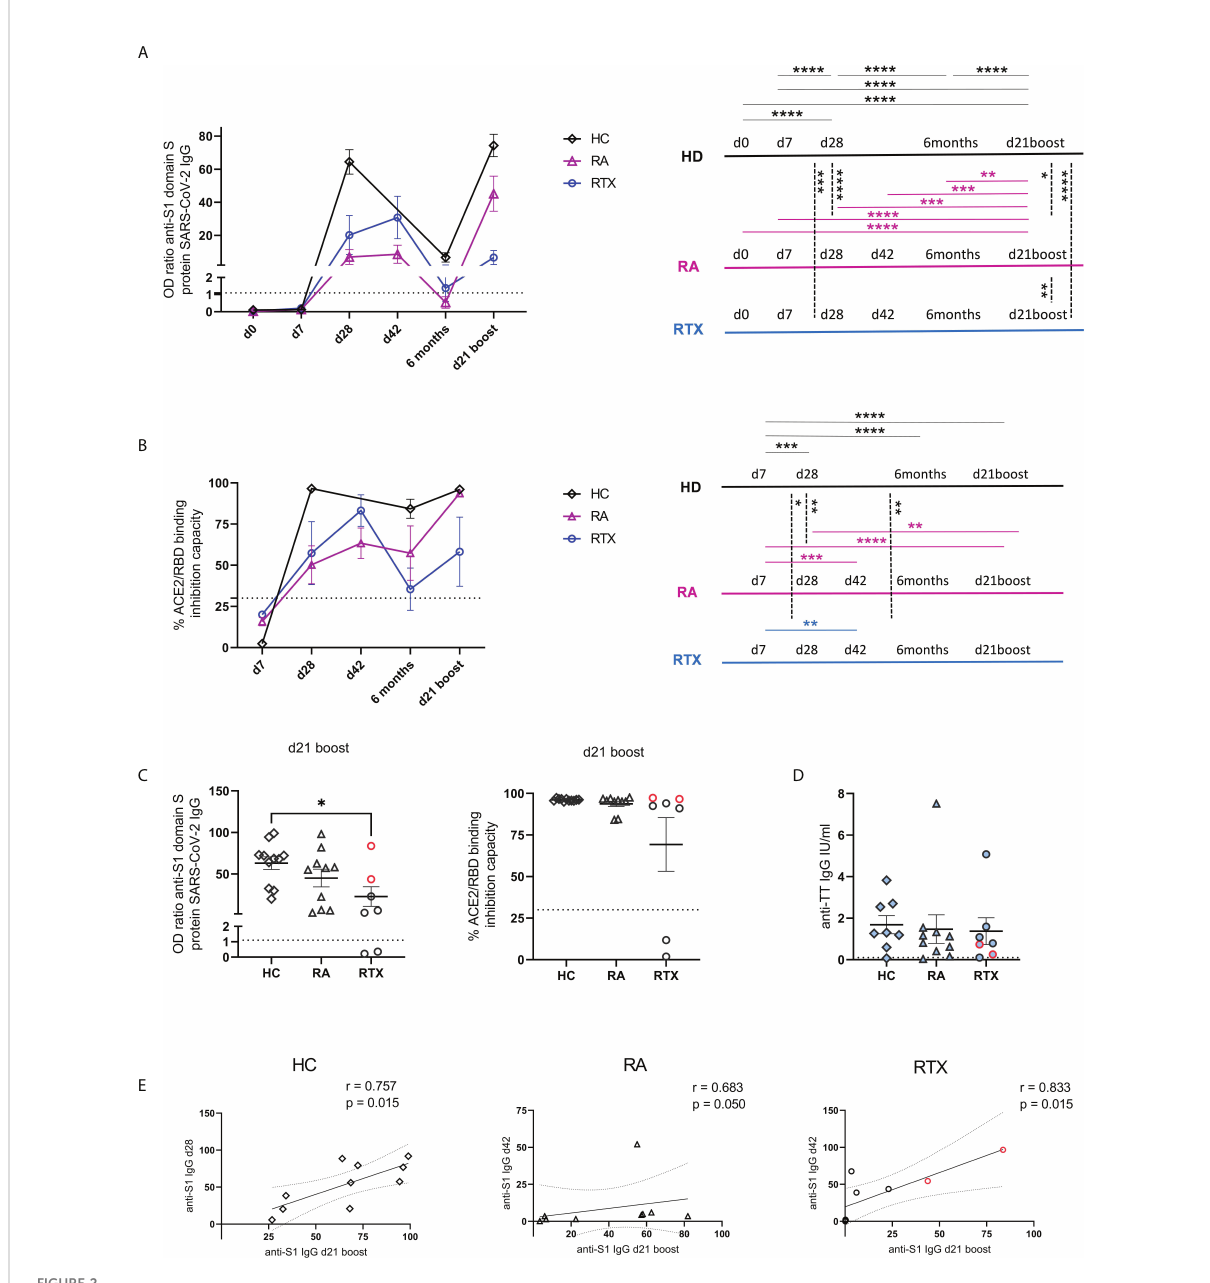
FIGURE 2 Trajectory of humoral response upon anti-SARS-CoV-2 vaccination. Humoral immune response against SARS-CoV-2 for spike protein S1 IgG (A) and surrogate neutralization (B) over time in HC (n=10), RA group (n=10) and RTX treated patients (n=5, the two pre-infected patients are excluded). Threshold for positive test is indicated by dotted lines. The results of the statistical tests are depicted on the right. Humoral immune response against SARS-CoV-2 for spike protein S1 IgG, surrogate neutralization (C) and anti-TT IgG titers (D) at d21 boost in HC (n=10), RA (n=10) and RTX (n=7). Correlation between anti-spike S1 IgG at d28 (HD)/d42 (RA and RTX) with anti-S1 levels at d21 boost (E) . Mean with SEM (A-D) . Two way ANOVA with S ̌ ida ́ k ’ s post-test (A, B) . Kruskal-Wallis with Dunn´s post-test (C, D) . Spearman test (E) . *p < 0.05, **p < 0.01, ***p < 0.001, ****p < 0.0001. Color code: previously infected individuals are indicated in red; control TT results are indicated by blue fi lled